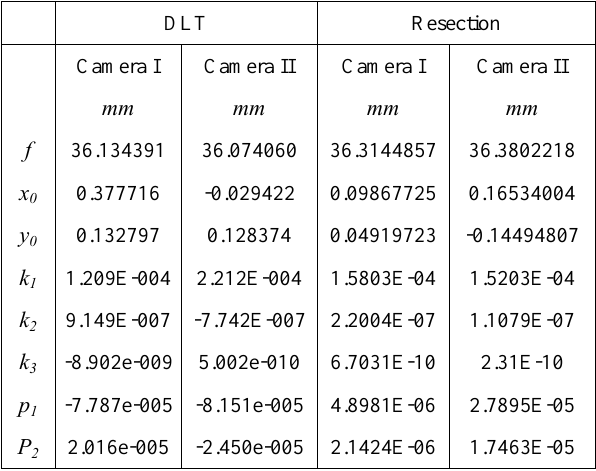
Table 1. The Result of Interior Orientation and Distortion Parameters